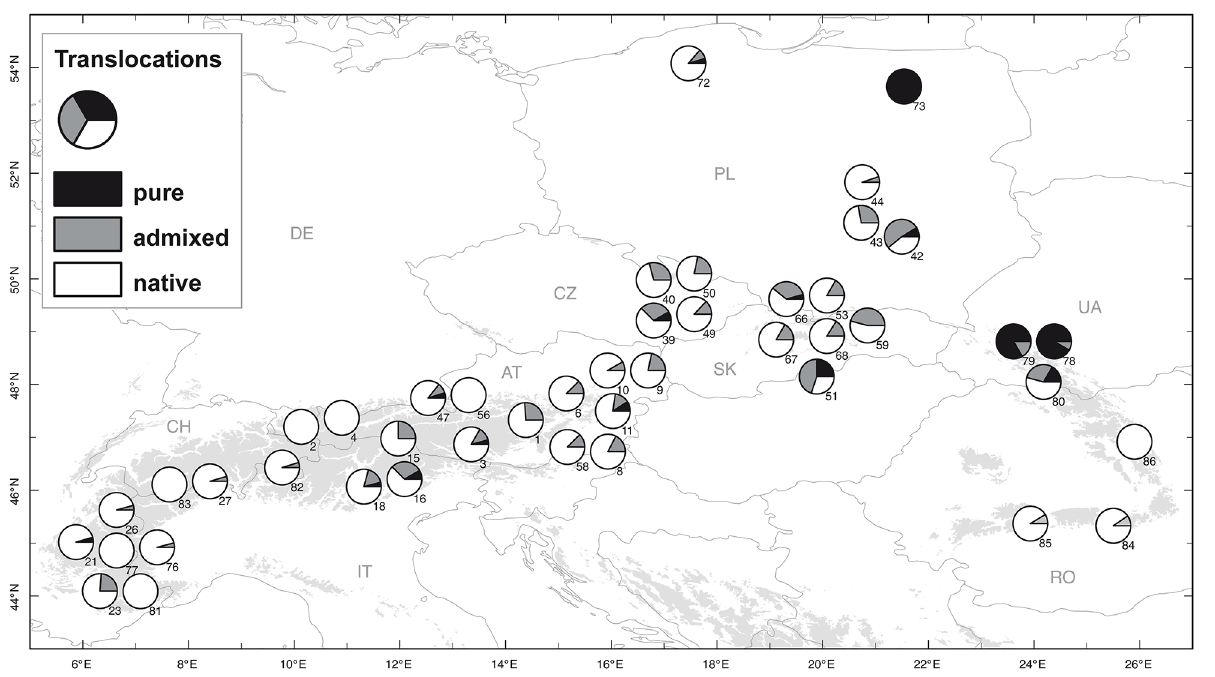
Fig 3. Non-native purebreds and admixture events detected with S TRUCTURE . Populations sampled within the native range and five populations sampled outside the native range (n°72, 73, 78, 79 and